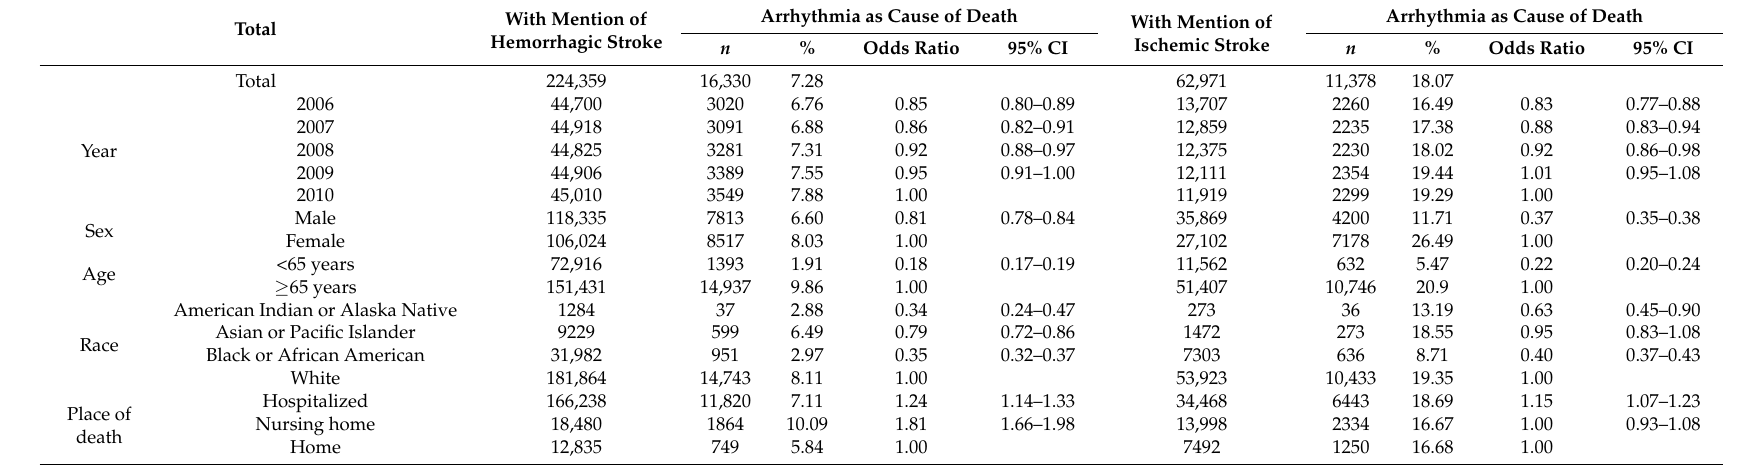
Table 3. The incidence and odds ratio of reporting arrhythmia as a cause of death on death certificates with mention of hemorrhagic and ischemic